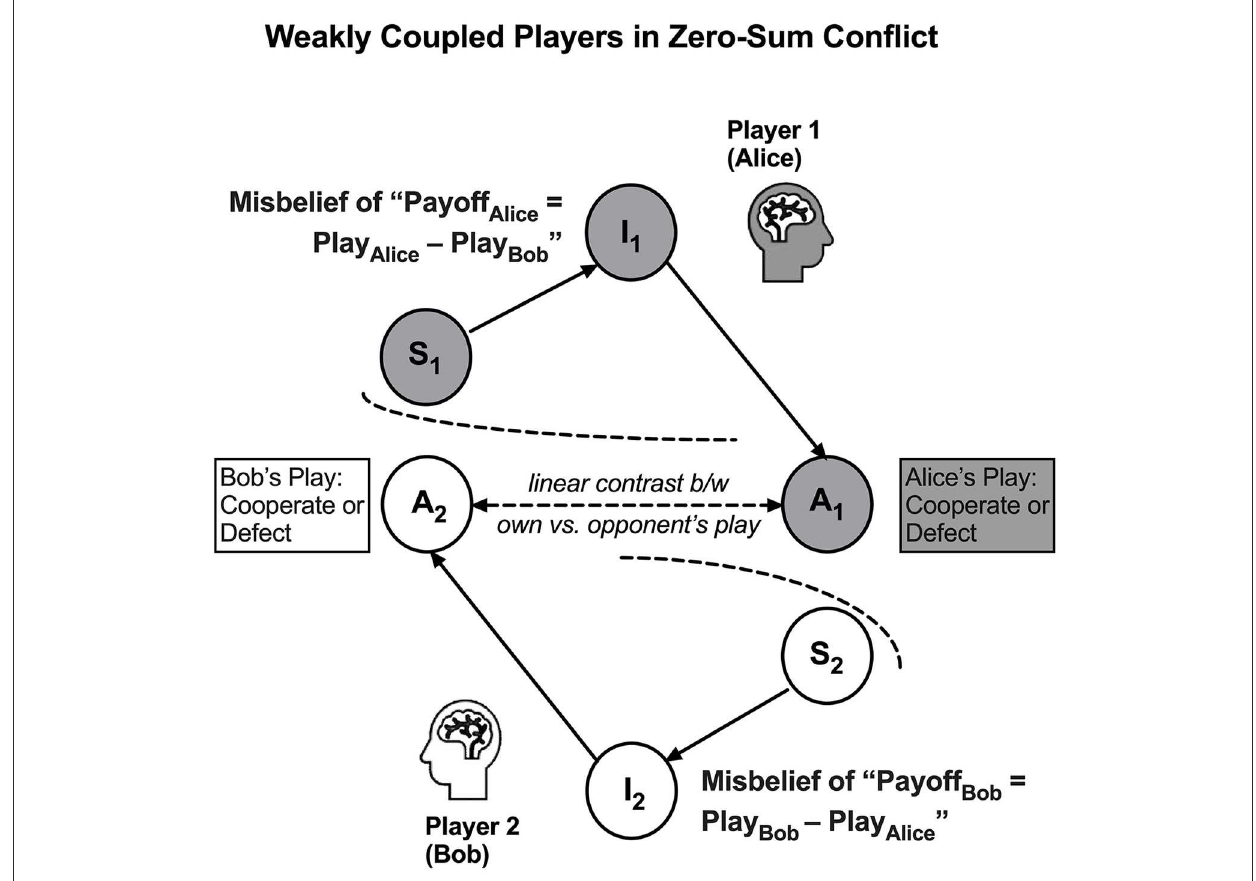
FIGURE5 An under-coupling ensues in a dyadic system when the players become blind to one another’s active inference engine, especially those covert, sensory, and internal states (S 2 ) and (I 2 ). Due to the under-coupling, the players tend to misattribute that the results are determined by the linear contrast between their plays, i.e., misbeliefs of Payoff Alice = Play Alice – Play Bob and Payoff Bob = Play Bob – Play Alice , as if they are competing in a zero-sum one-dimensional tug-of-war.